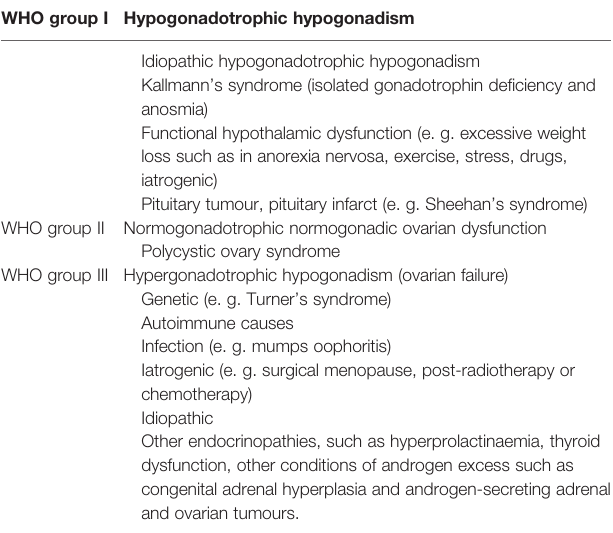
TABLE 1 | World Health Organization (WHO) group anovulation classi fi cation (28). WHO group I Hypogonadotrophic